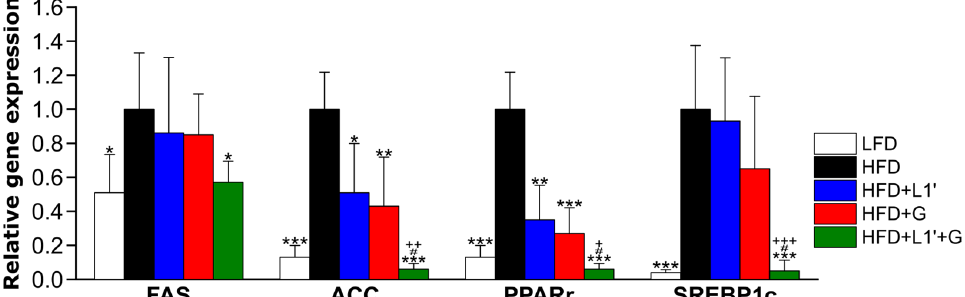
Figure 4. Combining L. plantarum HAC03 and G. cambogia has a synergic effect on decreasing mRNA expression of fatty acid synthesis. Relative gene expression related to fatty acid synthesis in the MAT. Fatty acid synthase, FAS; acetyl-CoA carboxylase, ACC; peroxisome proliferator activated receptor gamma, PPAR 𝛾 ; sterol regulatory element binding protein 1c, SREBP1c. All genes are normalized to expression of β -actin. The data are presented as mean ± SD ( n = 8). A one-way ANOVA with Dunnett’s comparison test was used for comparison with HFD groups. * p < 0.05, ** p < 0.01, *** p < 0.001. A Student’s two-tailed t -test was used for analysis of difference between experimental groups. # < 0.05 between HFD + G group and HFD + L1 ′ + G group. + < 0.05, ++ < 0.01, +++ < 0.001 between HFD + L1 ′ group and HFD + L1 ′ + G group.